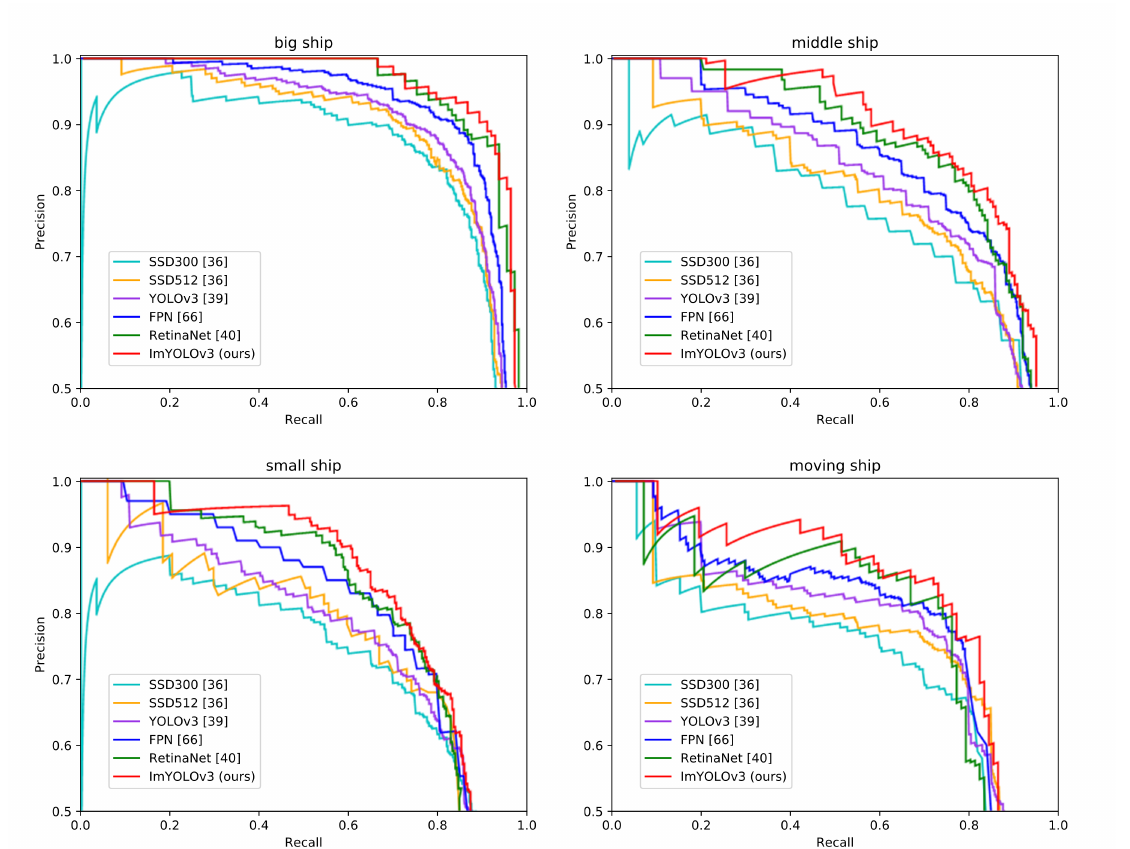
Figure 8. Precision–recall curves of different detection methods on four ship